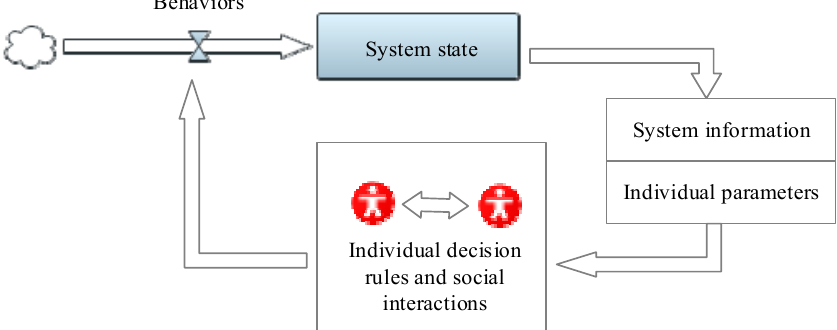
Figure 1. The conceptual framework of the hybrid simulation approach.